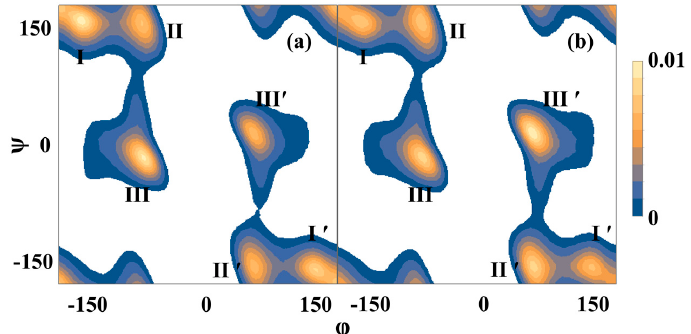
Figure 4. Ramachandran plots for the spacer region (residues 82–107) for ( a ) AP and ( b ) AA simulations. Data is shown for the 300 K replicas. Three basins (and their mirror images, indicated by primes) were found. Basin I corresponds to β -turns and β -sheets, basin II corresponds to β -turns, 3 1 -helices, and coils, and III corresponds to 3 10 -helices and α -helices.